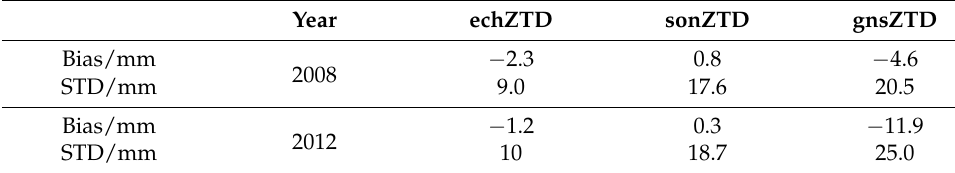
Table 1. Statistics of differences between occZTD and echZTD, sonZTD and